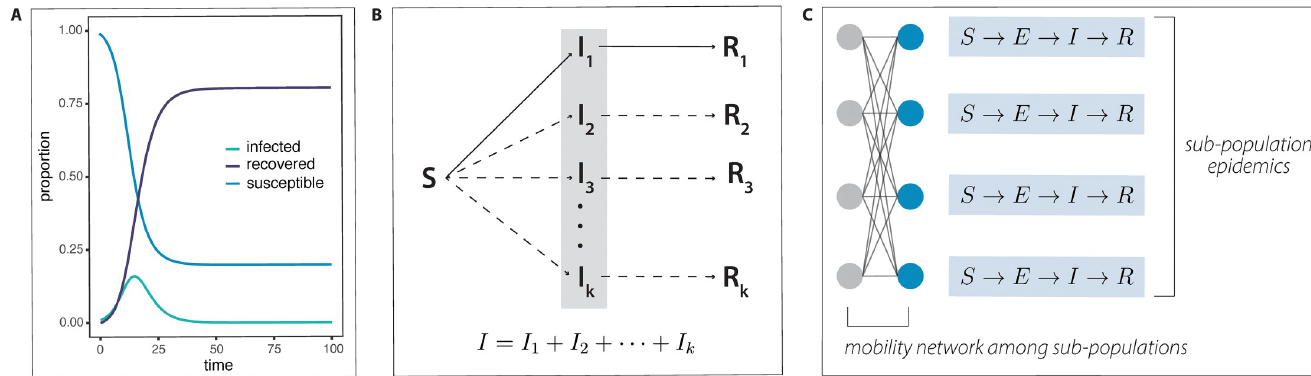
Fig 3. SIR models. (A) Proportions of susceptible, infected, and recovered individuals over time for an infection rate of 60% and a recovery rate of 30% per generation in a standard SIR model, as in Kermack and colleagues [91]. (B) Multistrain SIR model, as in Gordo and colleagues [93]. I 1 , ... , I k represent infected infections with strains 1, ... , k . (C) SEIR (Susceptible Exposed Infectious Recovered) model with population substructure, as in Chang and colleagues